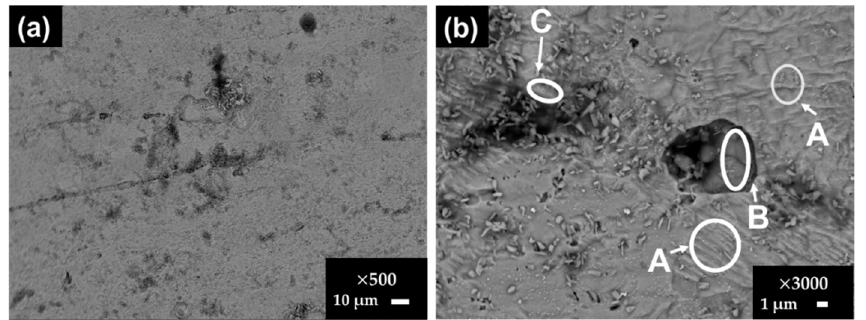
Figure 5. SEM images of stainless steel SS430 surface, after removal of the layer formed during the exposure for 30 days to SS1 cement extract solution: ( a ) × 500 and ( b ) × 3000 magnification (zones A, B, C).